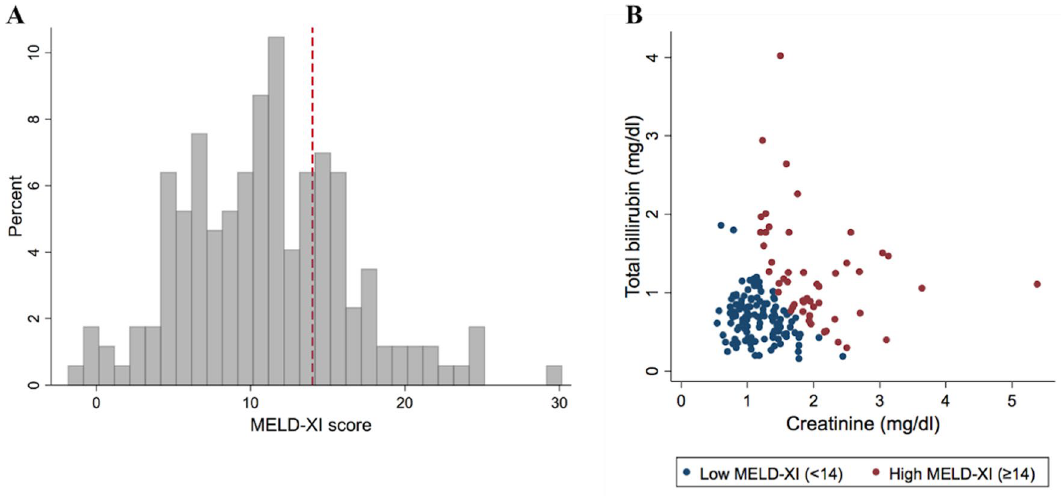
Figure 1. Distribution of the MELD-XI score and the components. The distribution of the MELD-XI score ( A ) and the creatinine and total bilirubin levels that are components of the MELD-XI score ( B ). The dashed red line indicates a MELD-XI score of 14.